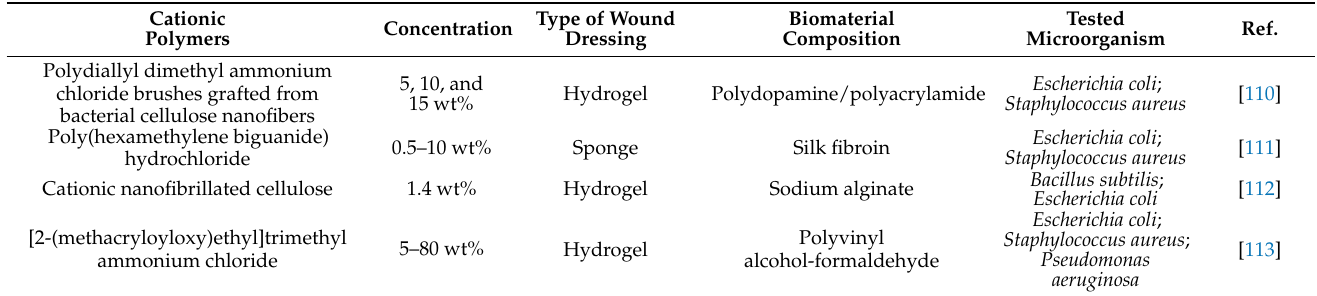
Table 6. Antibacterial cationic-polymer-loaded biomaterials for wound healing applications. Cationic